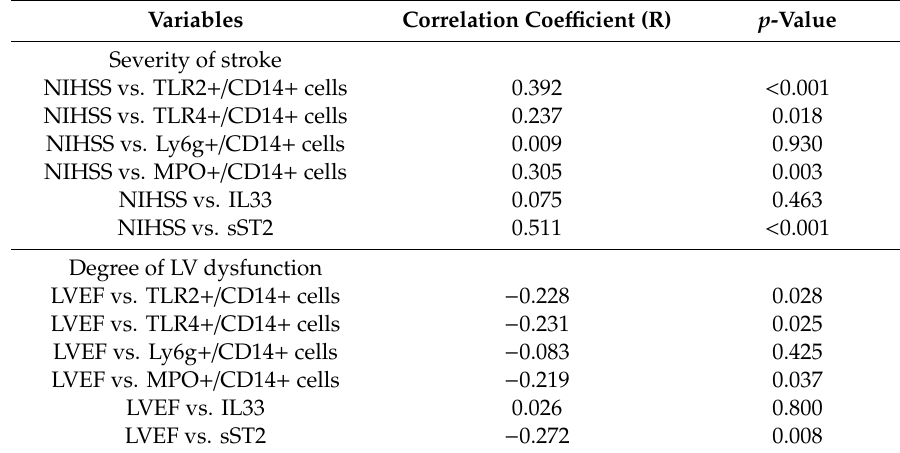
Table 2. Correlation of circulatory inflammatory biomarkers to the severity neurological dysfunction and impairment of heart function.